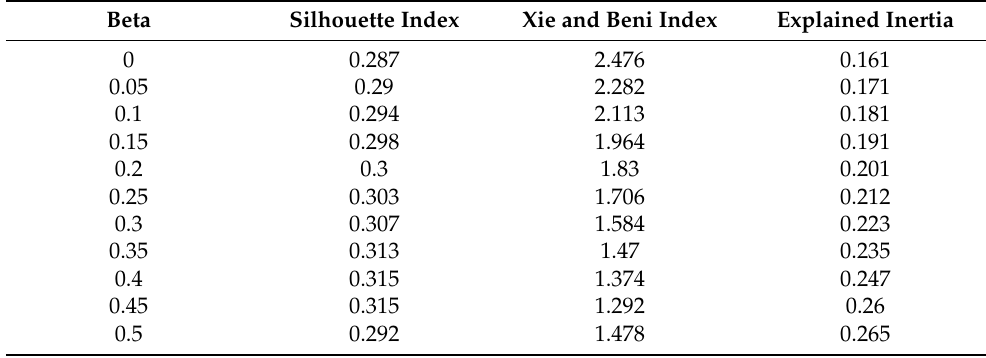
Table 3. Some indices with ascending β values.